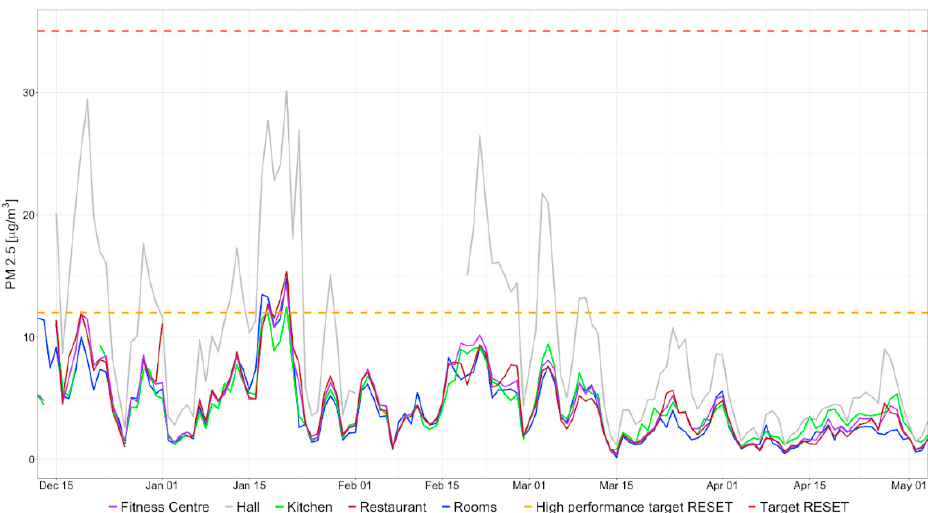
Figure 6. Concentrations of PM 2.5 ( μ m/m 3 ) detected in the different environments monitored along the whole period of